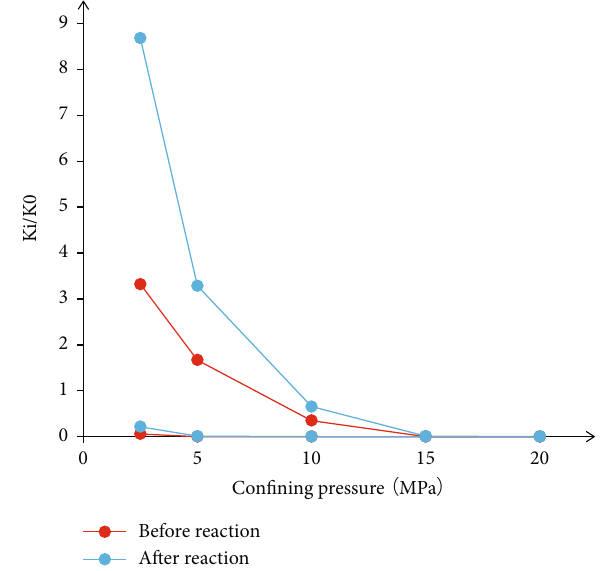
Figure 9: Stress sensitivity of shale before and after interaction with 15000mg/L NaCl solution for 48